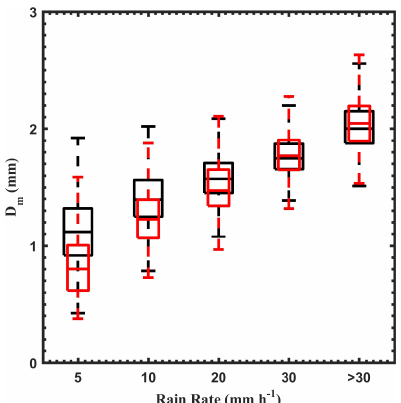
Figure 12. Distribution of D m at different rain rates for wet and dry spells. The horizontal line within the box represents the median value. The boxes represent data between the first and third quartiles, and the whiskers show data from the 12.5 to 87.5 percentiles. Black represents wet spells, and red represents dry